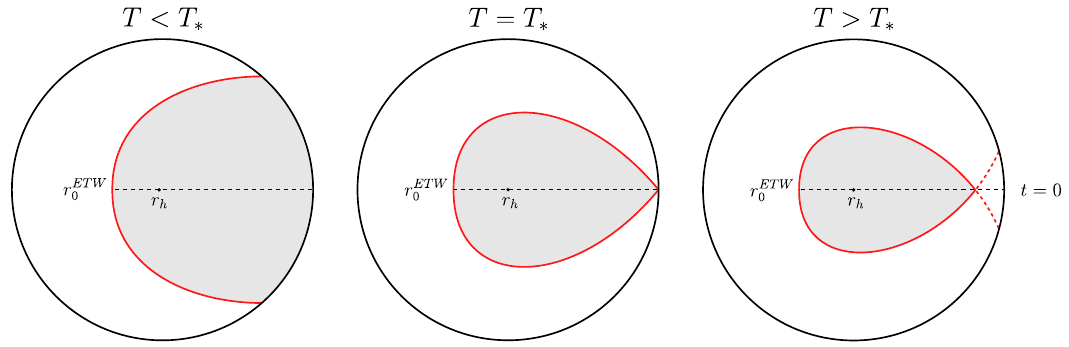
Figure 2 . Euclidean ETW brane trajectories for different values of the brane tension. The shaded regions are the bulk regions that we keep from the original Euclidean/Schwarzschild geometry without an ETW brane. Below the critical tension, T < T ∗ , there are sensible solutions with the brane intersecting the asymptotic boundary at times t > 0 ; at T = T ∗ the brane intersects the asymptotic boundary at t = 0 ; for T > T ∗ , the brane intersects itself before reaching the asymptotic boundary and we lose the Euclidean path integral construction of the state dual to the t = 0